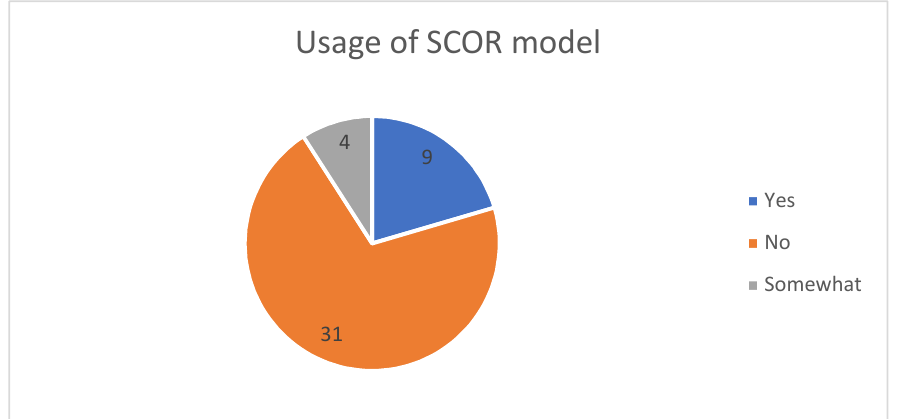
Figure 10. Overview of usage of the SCOR model.